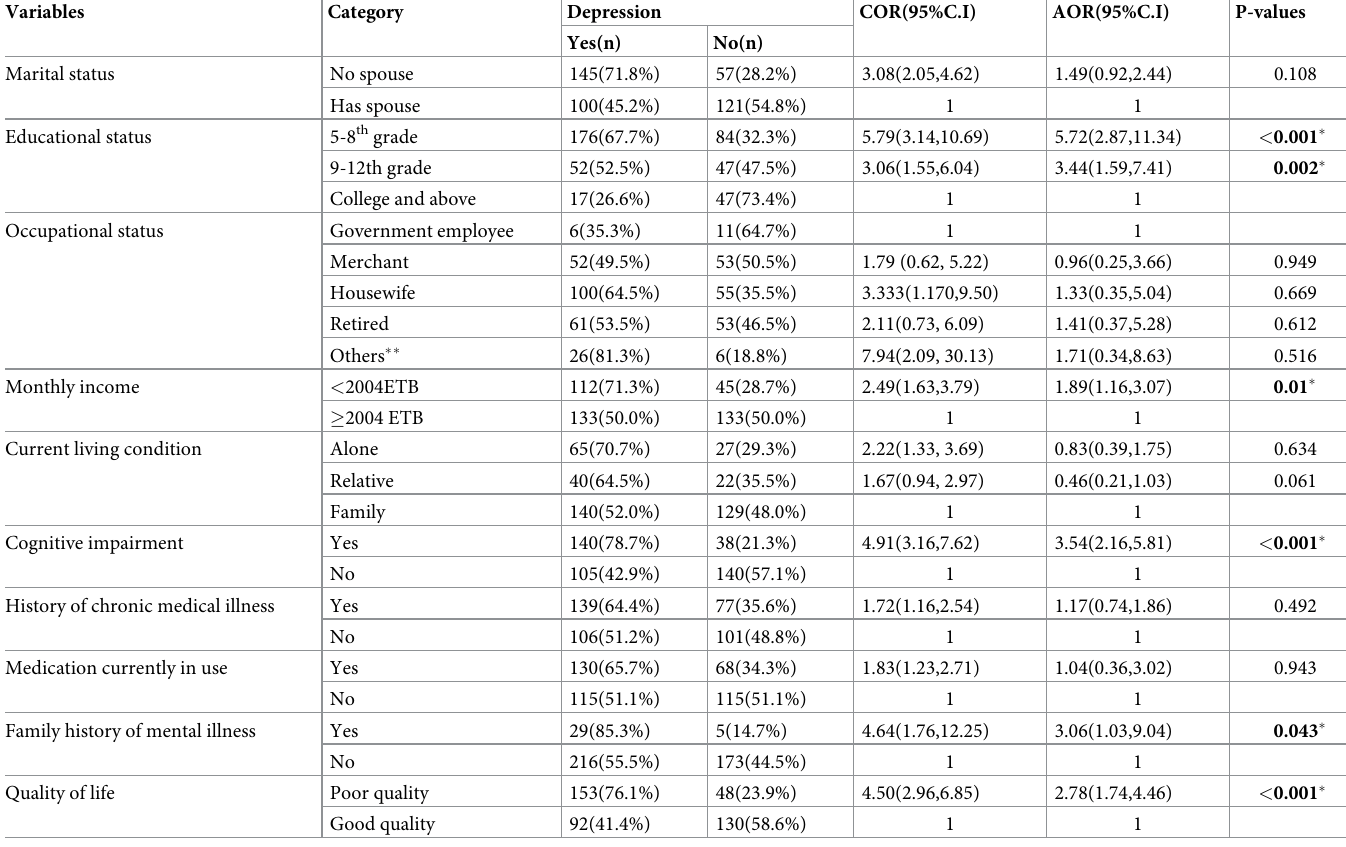
Table 4. Bivariate and multivariable logistic regression analysis results of depression in Bahir Dar city administration, northwest, Ethiopia, 2020 (n =